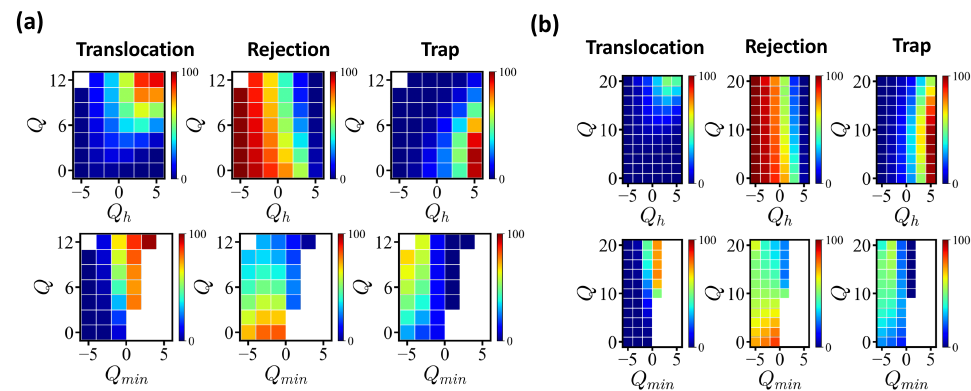
Figure 5. The percentages of translocated/rejected/trapped sequences (in the reverse direction) with t w = 1.6 × 10 5 MCT ( a ) for exactly enumerated N = 20 sequences and ( b ) for 10 7 randomly created sequences of N = 40. The top panels show the dependencies on Q h and Q and the bottom panels show the dependencies on Q min and Q . Color codes are presented in neighboring color